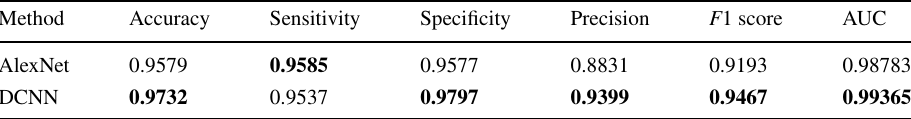
comparison of DCNN and AlexNet architectures on ZJU